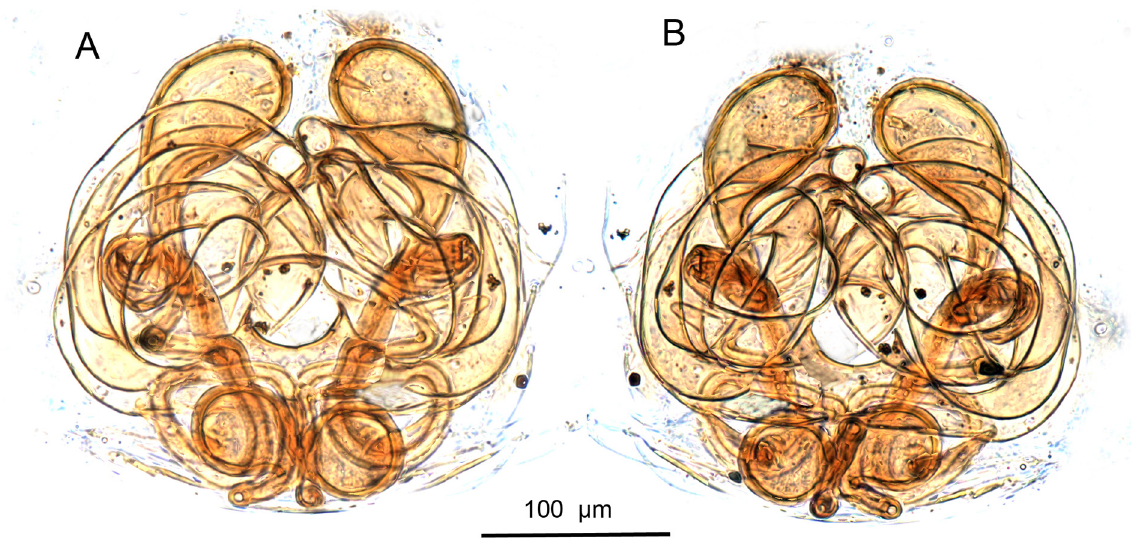
Fig. 3. Hortipes gigapophysalis sp. nov. A . epigyne cleared in methyl salicylate, ventral view. B . idem, dorsal